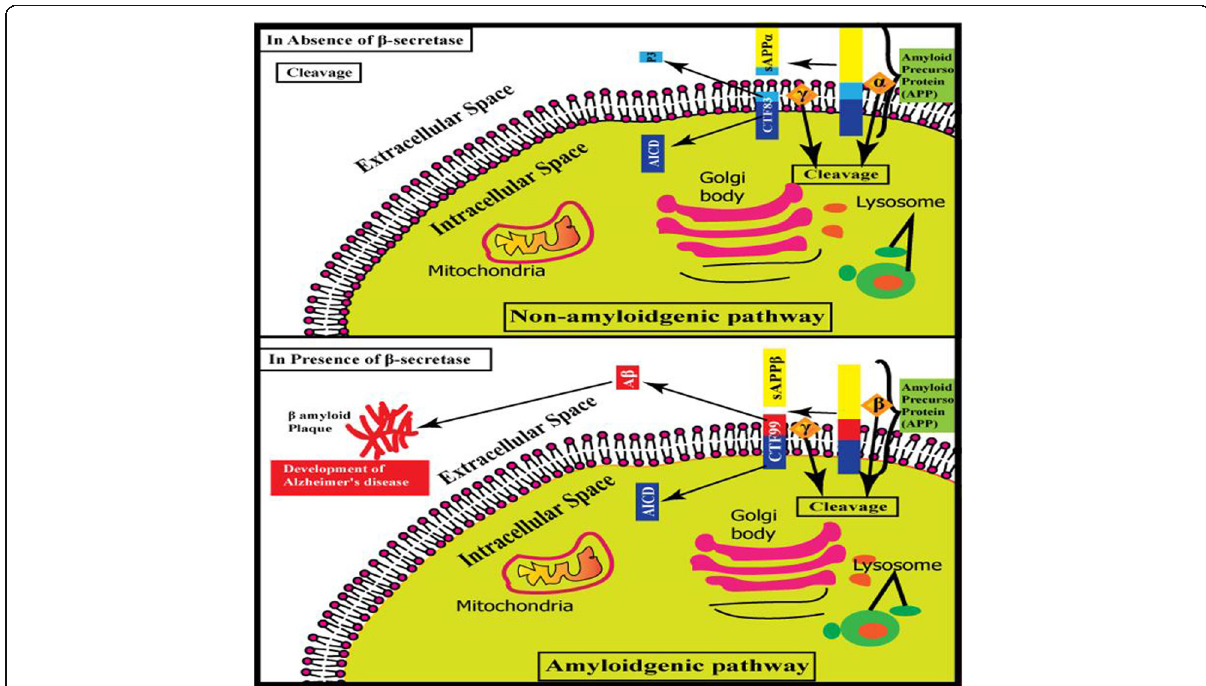
Fig. 1 Role of β -secretase in Alzheimer ’ s disease and amyloidogenic and non-amyloidogenic pathways. In non-amyloidogenic pathway, cleavage of APP sequentially by α - and γ -secretase produces sAPP α and soluble P3, respectively. On the other hand, in amyloidogenic pathway, β -and γ - secretase produces sAPP β and insoluble A β protein, respectively, leading to the formation of β amyloid plaques. Matured APP and β -secretase are transported to the plasma membrane by Golgi body. A portion of APP is degraded by